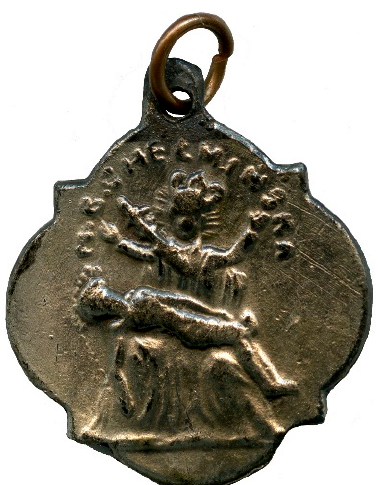
Figure 2. Holy medal with Our Lady of Sorrows of Chełmno, height 26 mm (with a pendant integrally connected with the holy medal), width 22 mm; Our Lady of Chełmno with the inscription above: The image of Merciful Christ. It is located in the collections of—The Museum of the Chełmno Land MZCH/E/982.